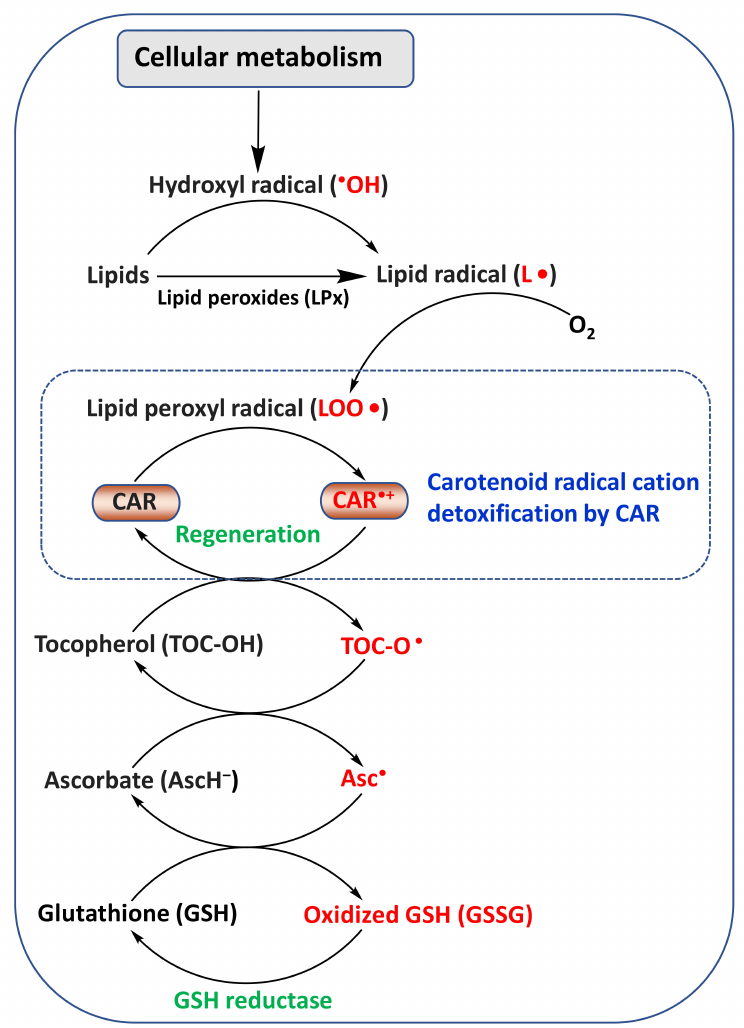
Figure 2. The lipid peroxyl radical (LOO • ) scavenging/detoxification by carotenoids (CARs). The carotenoid radical cation (CAR • +) can be regenerated in the presence of tocopherol (vitamin E), ascorbate (vitamin C), and